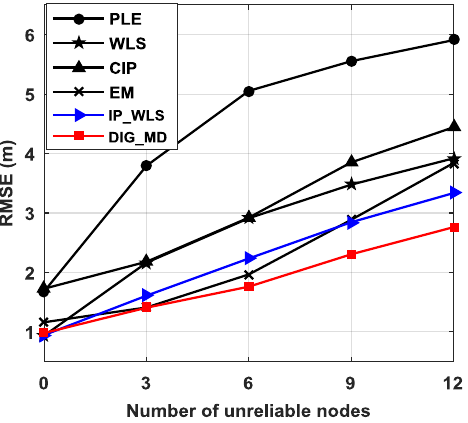
Figure 6. RMSE vs. the number of unreliable nodes when